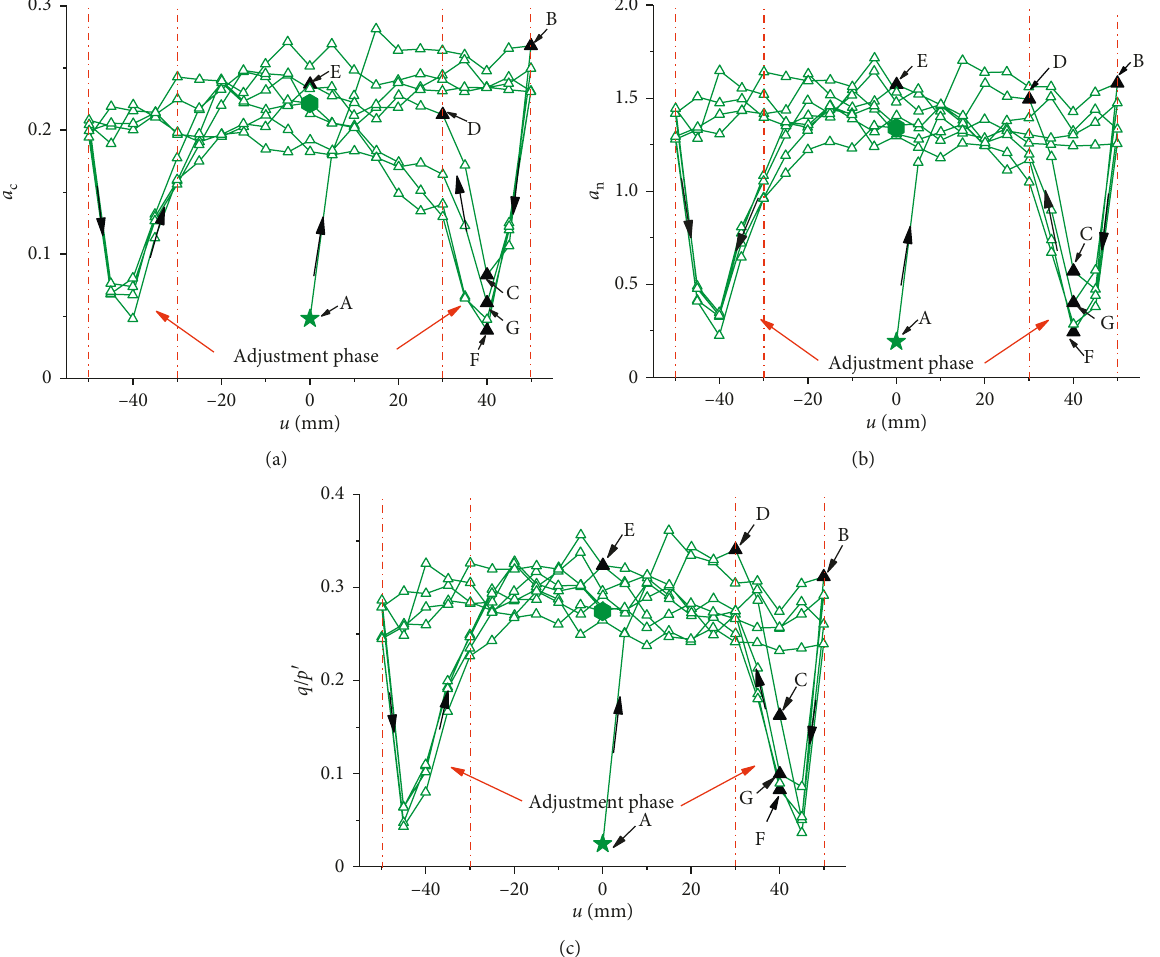
Figure 21: Schematic of adjustment phase for SY_2_15: (a) a